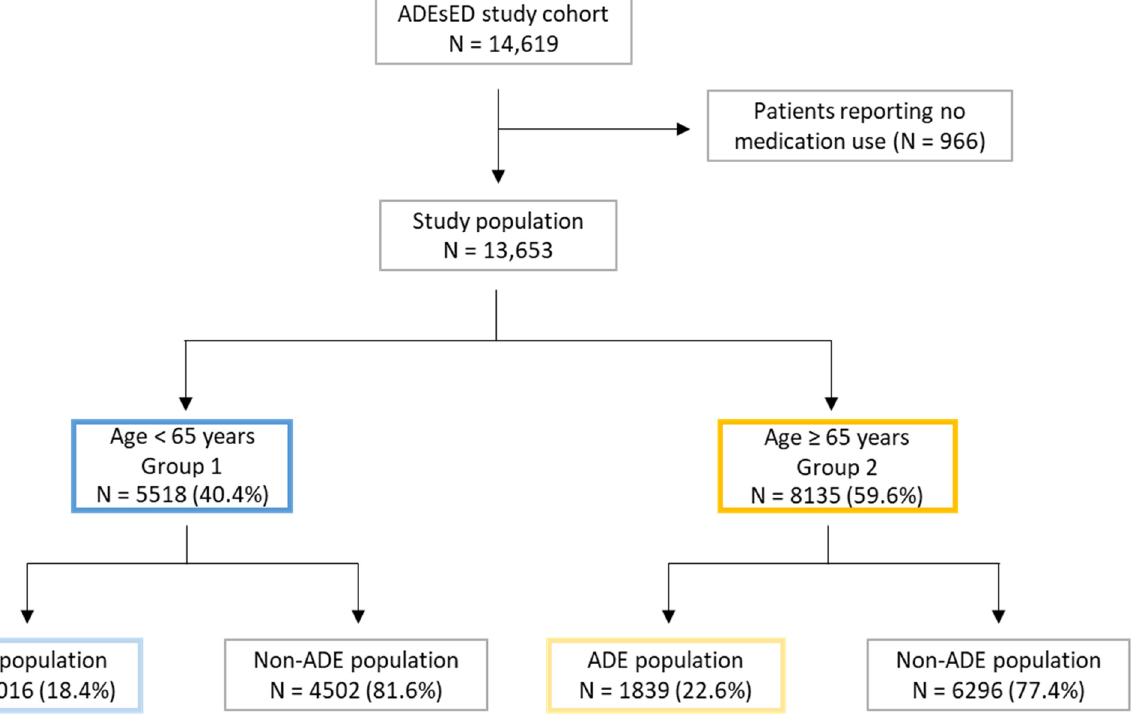
Figure 1. Flowchart of the study population. ADE, adverse drug event; ADEsED: adverse drug events at emergency department (ADEsED); ED, emergency department. ADEsED study is registered on ClinicalTrials.gov (NCT03442010, accessed on 25 August 2022).